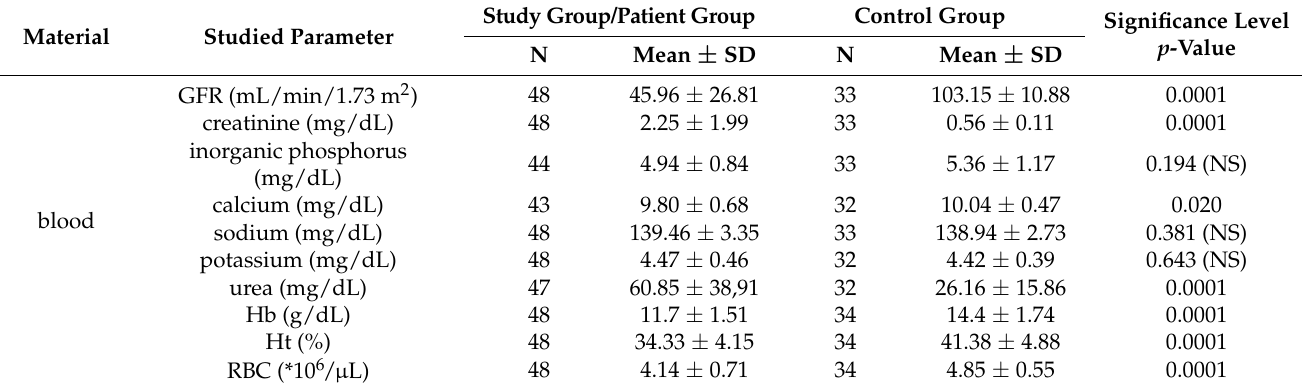
Table 1. The biochemical characteristics of the blood of studied population of